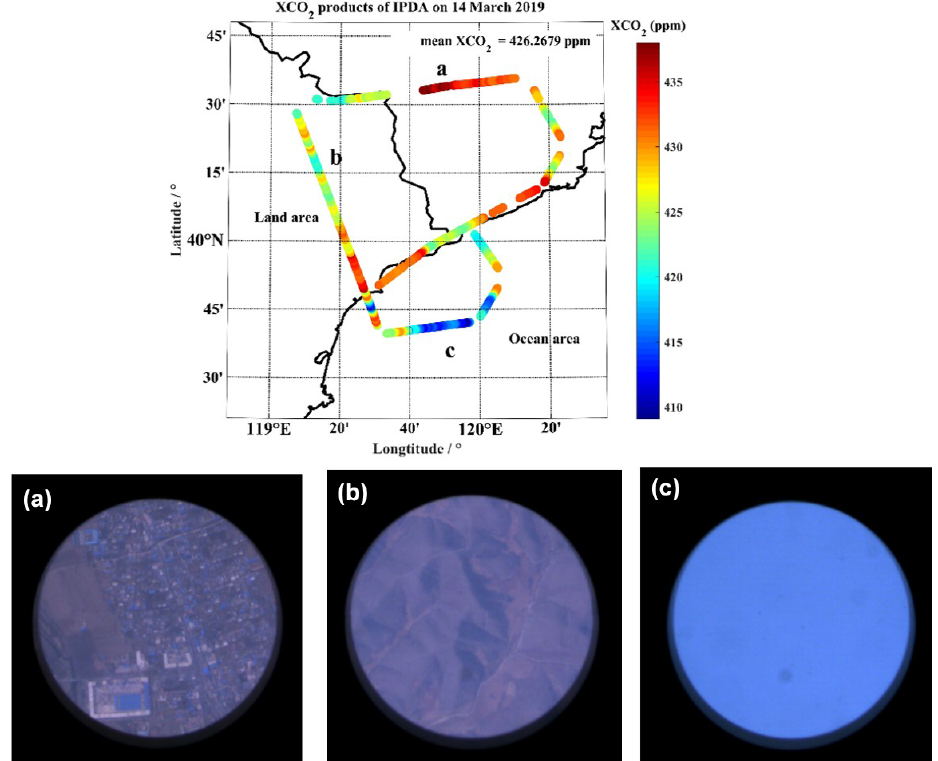
Figure 13. XCO 2 distribution on the flight trajectory and surface photos of typical areas on 14 March 2019. Among them, (a) represents the urban residential area, (b) represents the mountain area, and (c) represents the ocean